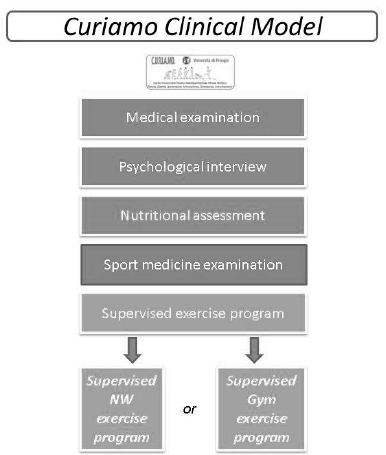
Figure 1. The “Centro Universitario Ricerca Interdipartimentale Attivit à Motoria” clinical model (De Feo et al., JEI 2011